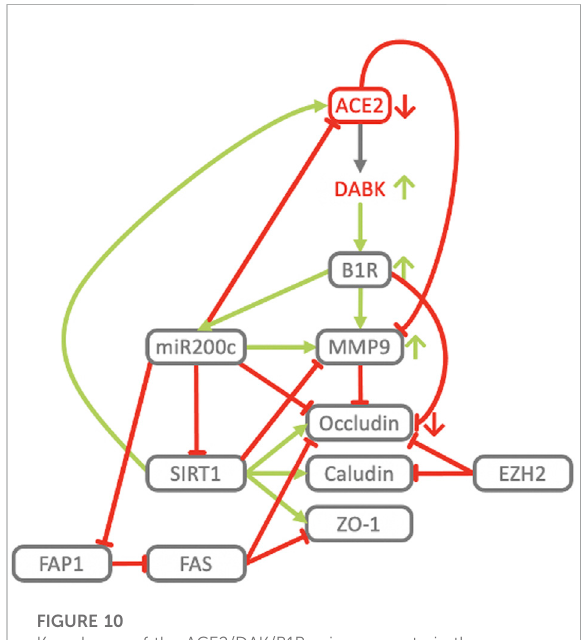
FIGURE 10 Key players of the ACE2/DAK/B1R axis cooperate in the downregulation of tight junction proteins and induction of MMP9. B1R stimulation results in the loss of Occludin expression at tight junctions and an increase of vascular permeability (Mugisho et al., 2019). In neuroin fl ammatory diseases B1R contributes to in fl ammation and loss of blood-brain-barrier integrity, while inhibition of B1R protects mice from focal brain injury by reducing blood-brain barrier leakage and in fl ammation (Raslan et al., 2010). Neutrophils engage the KKS to open up the endothelial barrier in acute in fl ammation (Kenne et al., 2019). Activation of B1R induces expression and secretion of MMP-9 and MMP-2 (Matus et